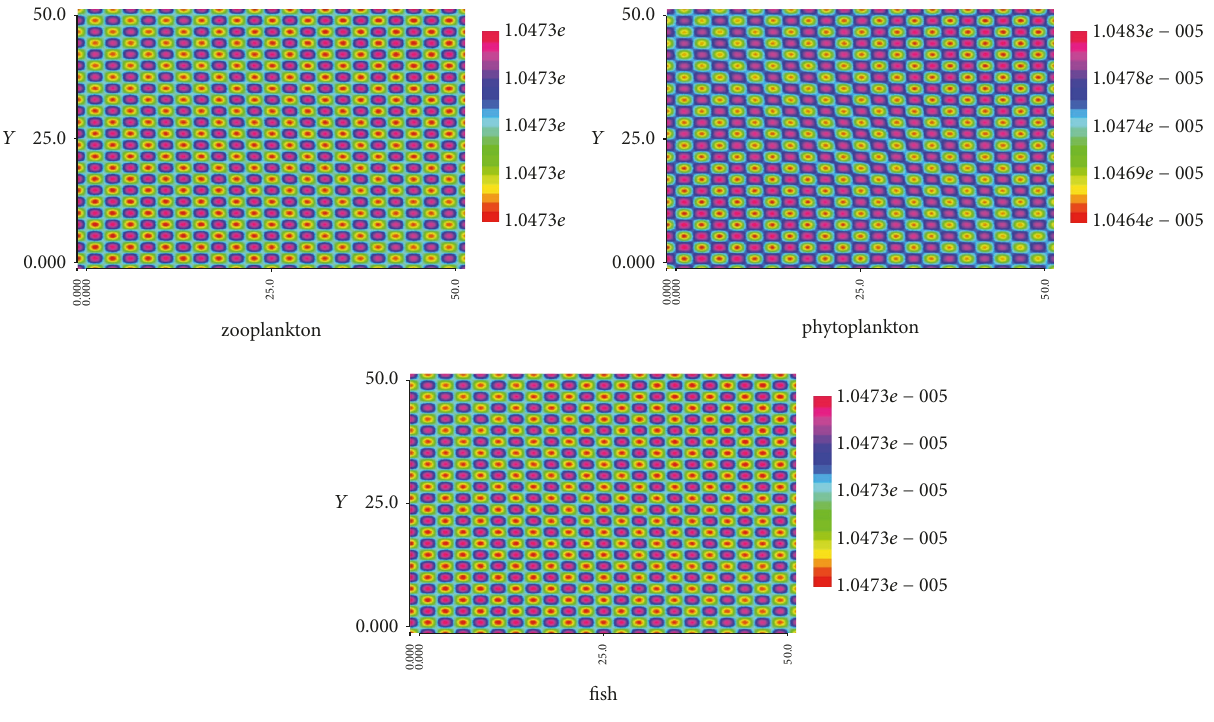
Figure 2: Spatial distribution of the system with 𝑏 0 = 0.25 and 𝛼 0 = 0.6 .